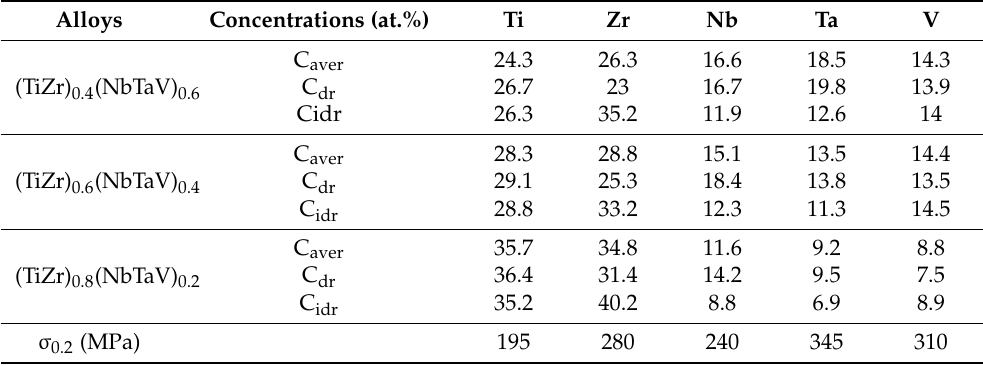
Table 1. The estimated bulk composition ( C aver ), the average composition of dendrite arms ( C dr ), and the average composition of interdendritic regions ( C idr ) for (TiZr) x (NbTaV) 1 − x HEAs. The yield strengths ( σ 0.2 ) of pure metals are also given [16]. Alloys Concentrations (at.%)